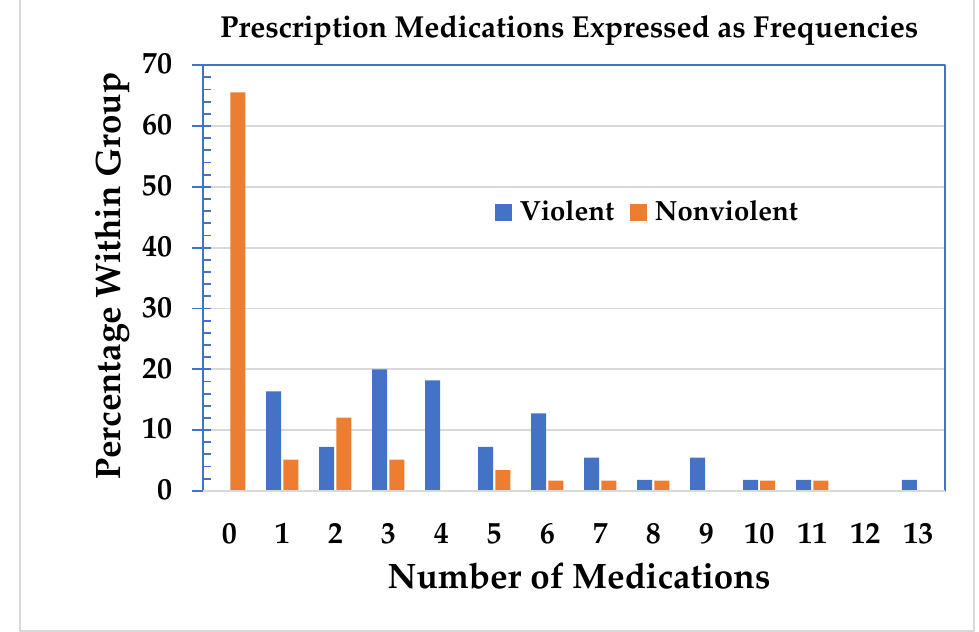
Figure 3. Comparison of groups with respect to the number of prescription medications. Table 3. Chi-square test of the distribution of the number of